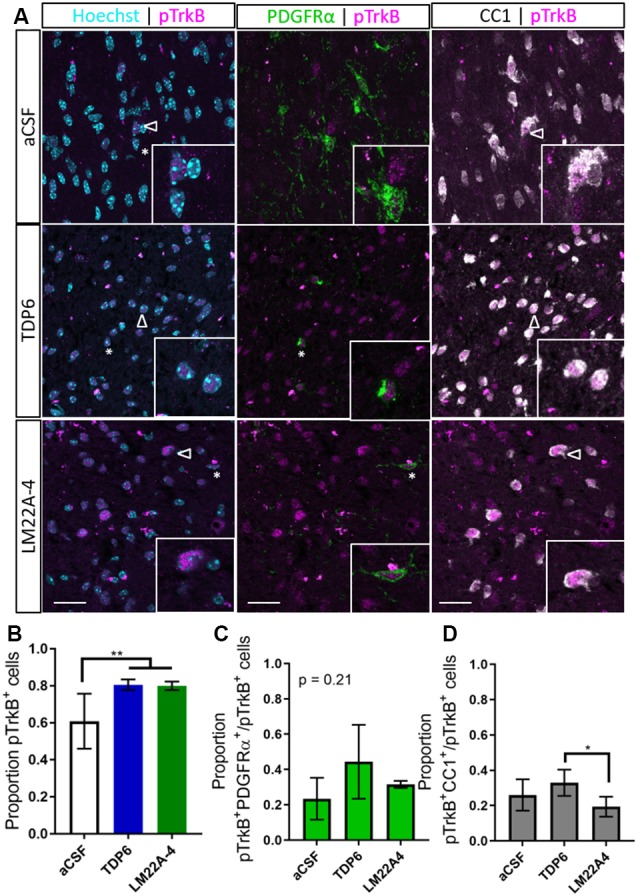
Phosphorylation of TrkB in the corpus callosum during remyelination is elevated following treatment with TDP6 and LM22A-4. (A) Representative micrographs of pTrkBS478-PDGFRα-CC1 immunostaining in the caudal corpus callosum of mice treated with aCSF vehicle, TDP6 or LM22A-4 (sagittal plane, scale bar = 20 μm). Asterisk: pTrkBs478+PDGFRα+ cell, open arrowhead: pTrkBs478+CC1+. Inset: enlarged image of marked cells. (B) Proportion of pTrkBs478+ cells increased (p = 0.0022) in the corpus callosum of mice treated with TDP6 and LM22A-4 compared to those that received aCSF vehicle (n = 4–8/group). (C) The proportion of pTrkBs478+ cells also PDGFRα+ was unchanged across the three different treatments (p = 0.21, n = 4–8/group), while (D) the proportion of pTrkBs478+CC1+ cells increased (p = 0.045) in mice that received TDP6 infusion compared to those receiving LM22A-4 (n = 4–8/group). One-way ANOVA with Tukey’s post hoc multiple comparisons, p < 0.05 considered significant. Mean ± SD plotted. Six-weeks cuprizone feeding commenced at 8 weeks of age, tissue collected at 15 weeks of age. *p < 0.05, **p < 0.01.